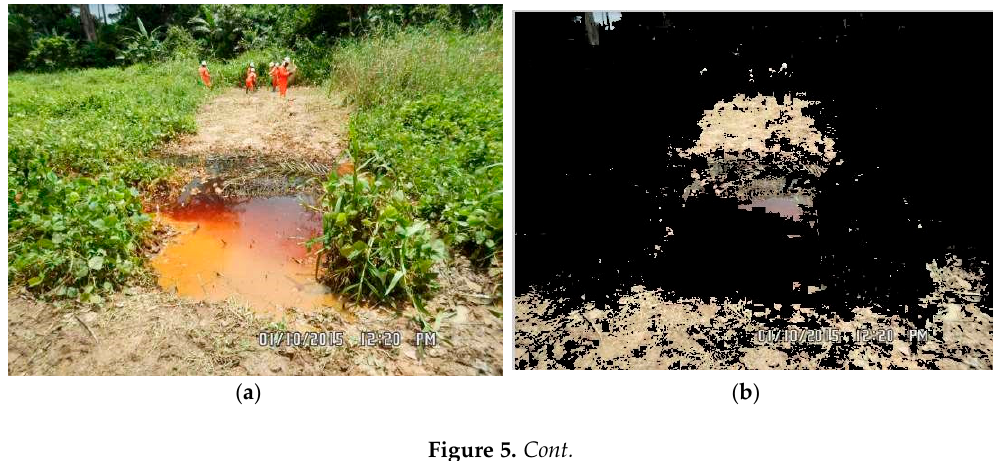
Figure 4. Effect of RGB color range overlap on color segmentation stage in spill detection algorithm. ( a ) Sample image OS25 with negative spill detection result; ( b ) Color Segmentation result for OS25 showing algorithm’s failure to eliminate dark green